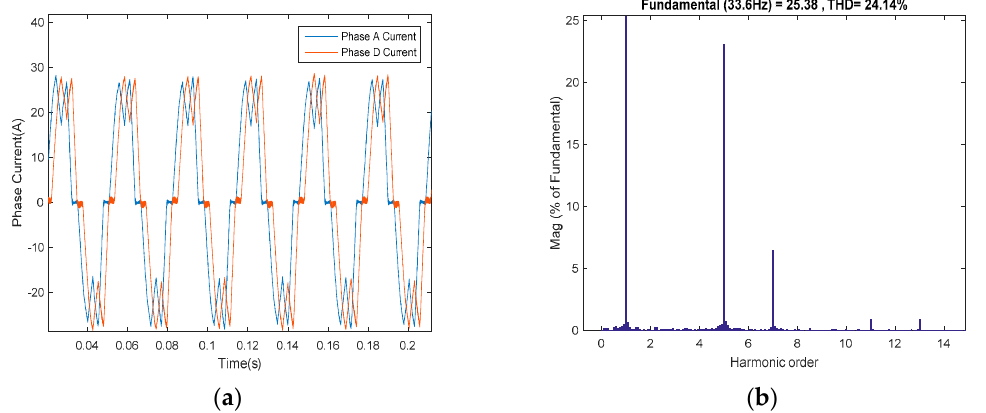
Figure 13. Experimental results without adopting the ADALINE-based voltage compensator when the motor speed is 500 rpm, ( a ) phase A and D currents and ( b ) THD for phase A.